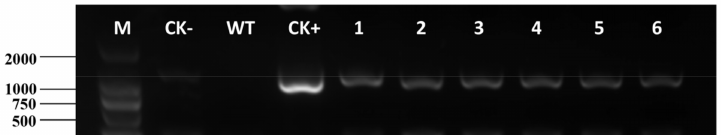
Figure 4. Molecular analysis of transgenic plants. PCR amplification of the htp gene (1026 bp). M: marker 2000; CK+: positive control (plasmid PBI-1300); CK − : negative control (H 2 O); WT: wild- type plant, lanes 1–6, putative